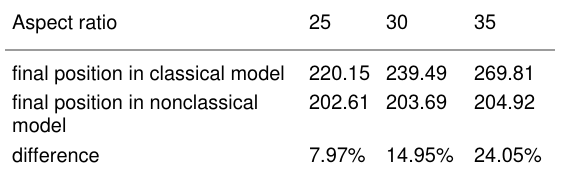
Table 6: Final position of the cylindrical gold nanoparticle in a 200 nm manipulation (length = 25 µm and aspect ratio = 35, 30 and 25) ac- cording to the classical and nonclassical Timoshenko beam models).